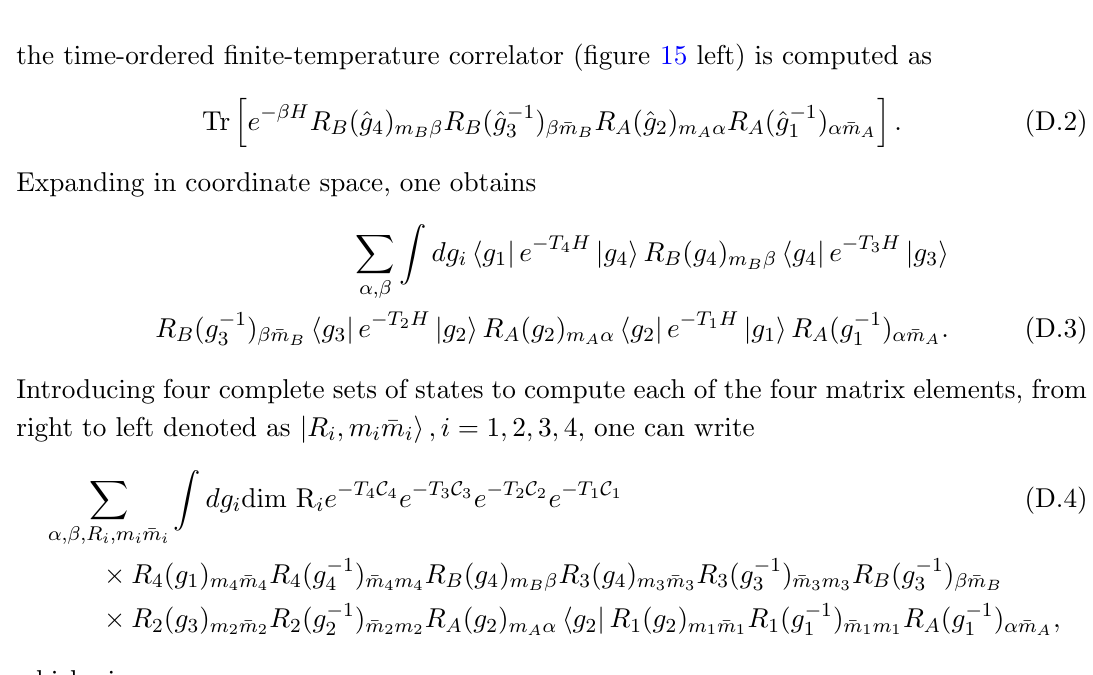
Figure 15 . Left: four-point correlator for the thermal particle-on-a-group model. Right: four-point correlator with crossed bilocal